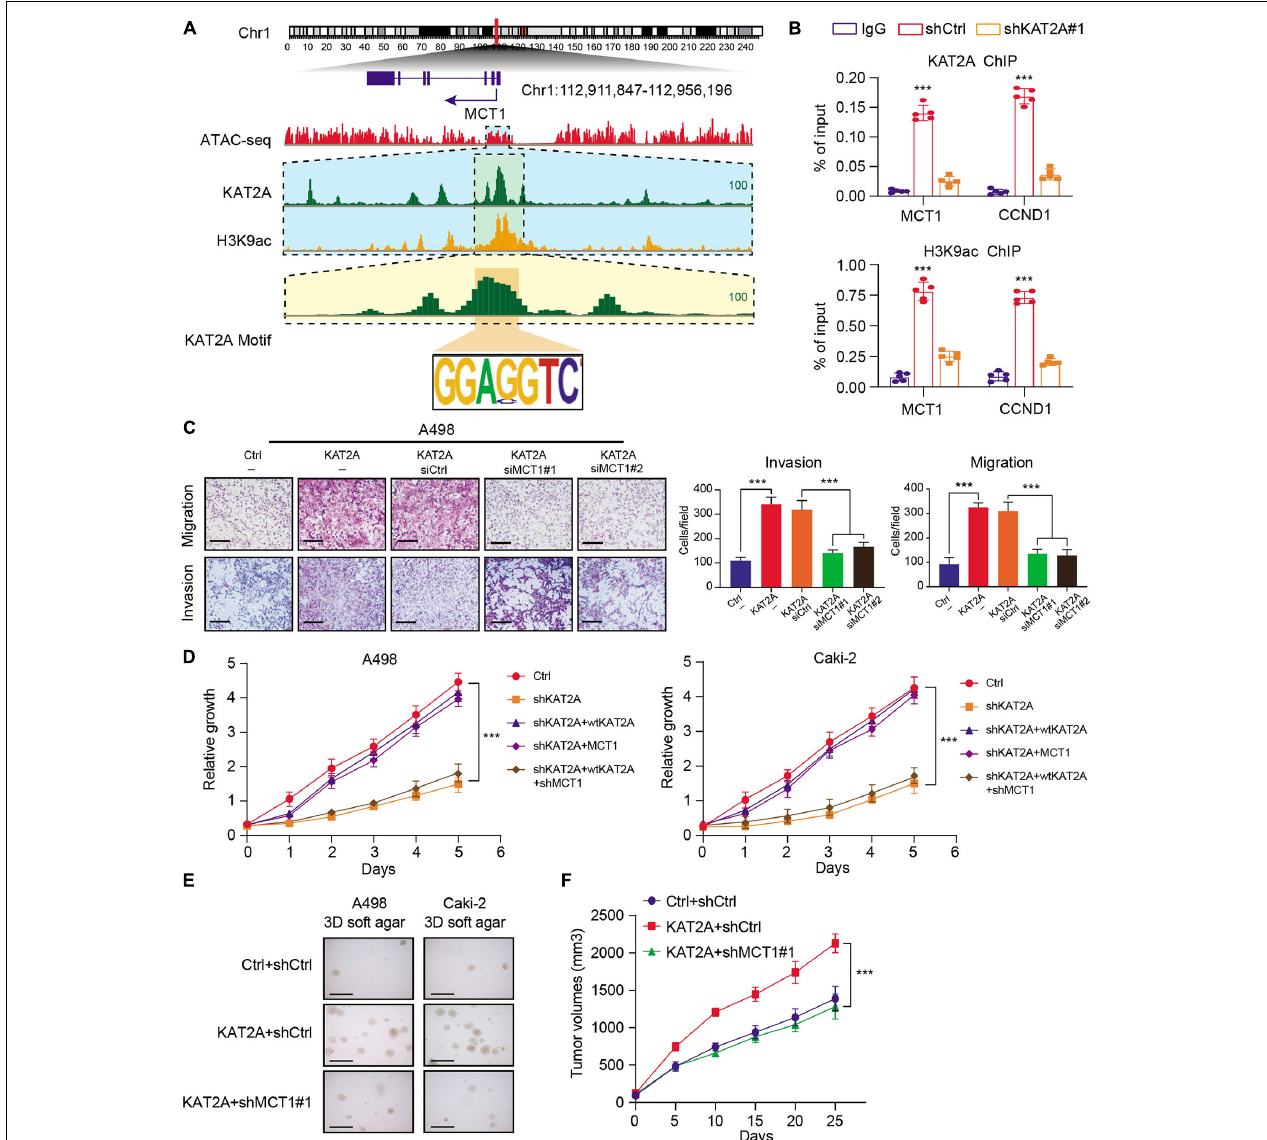
FIGURE 5 | KAT2A enhances the H3K9ac abundance at MCT1 promoter and depended on MCT1 to accelerate RCC malignant progression. (A) IGV diagram indicating the multiple tracks of KAT2A and H3K9ac binding signals at the MCT1 promoter loci, as indicated. (B) ChIP-qPCR experiment of KAT2A binding and H3K9ac in genes, as indicated. (C) Representative pictures (scale bars = 250 µ m, left) and quantification analysis (right) of cell migration and invasion abilities of KAT2A-overexpressed A498 cells transfected with the MCT1 siRNAs or controls. (D) CCK-8 assays of KAT2A knockdown Caki-2 and A498 cells underwent MCT1 overexpression or combined management of WT KAT2A restoration and scramble or MCT1 shRNA. (E) 3D soft-agar assays revealing that MCT1 knockdown could impair the growth ability of KAT2A-overexpressed RCC cells (A498 and Caki-2). (F) The tumor volume was assessed every other day, and tumor growth curves were generated. *** P <